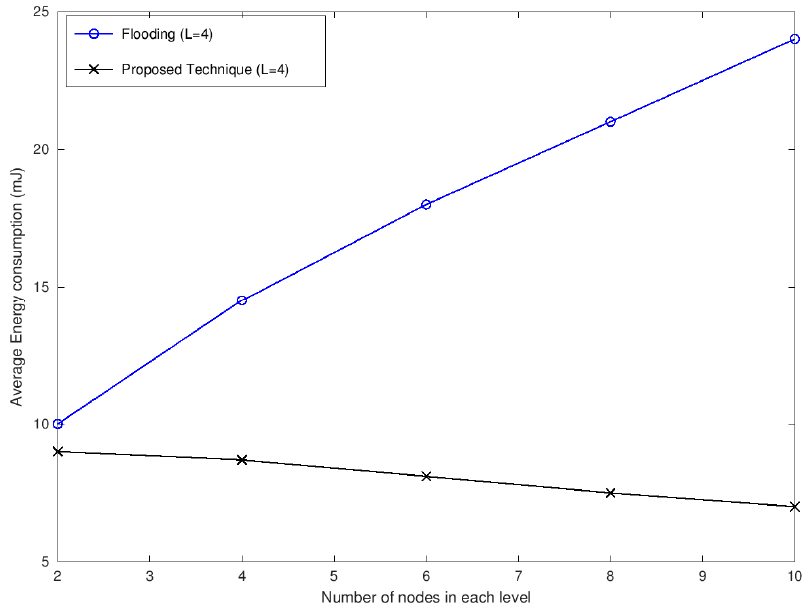
Figure 7. Average energy consumption versus the number of destination nodes.